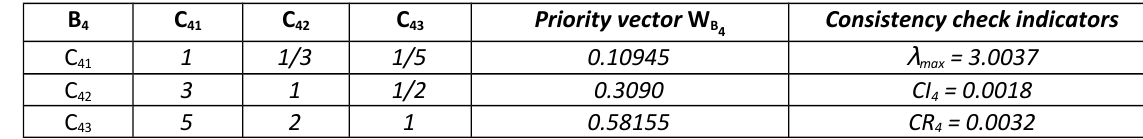
Table 7. Alternative matrix B